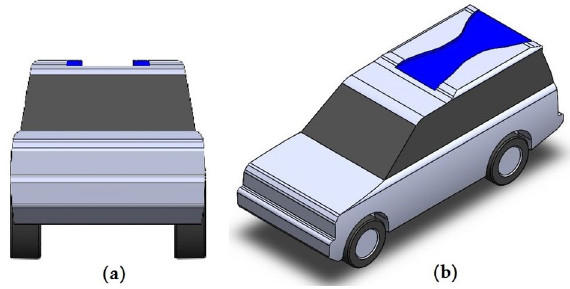
Figure 3. LR Discovery model with the modified roof ( a ) front view and ( b ) ISO view.